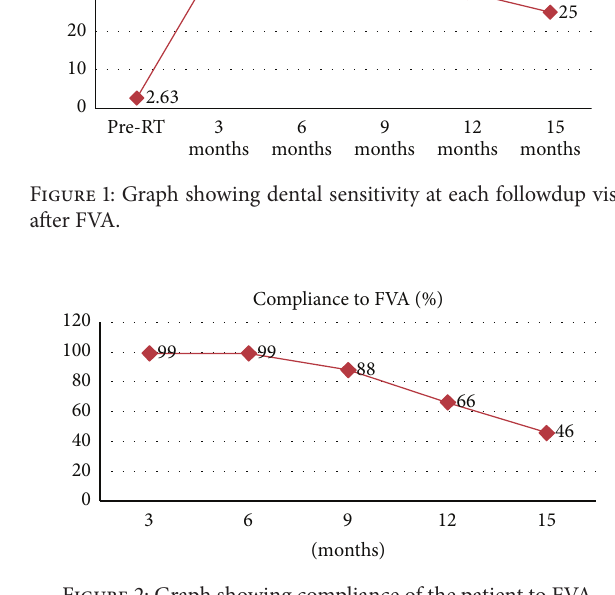
Figure 2: Graph showing compliance of the patient to